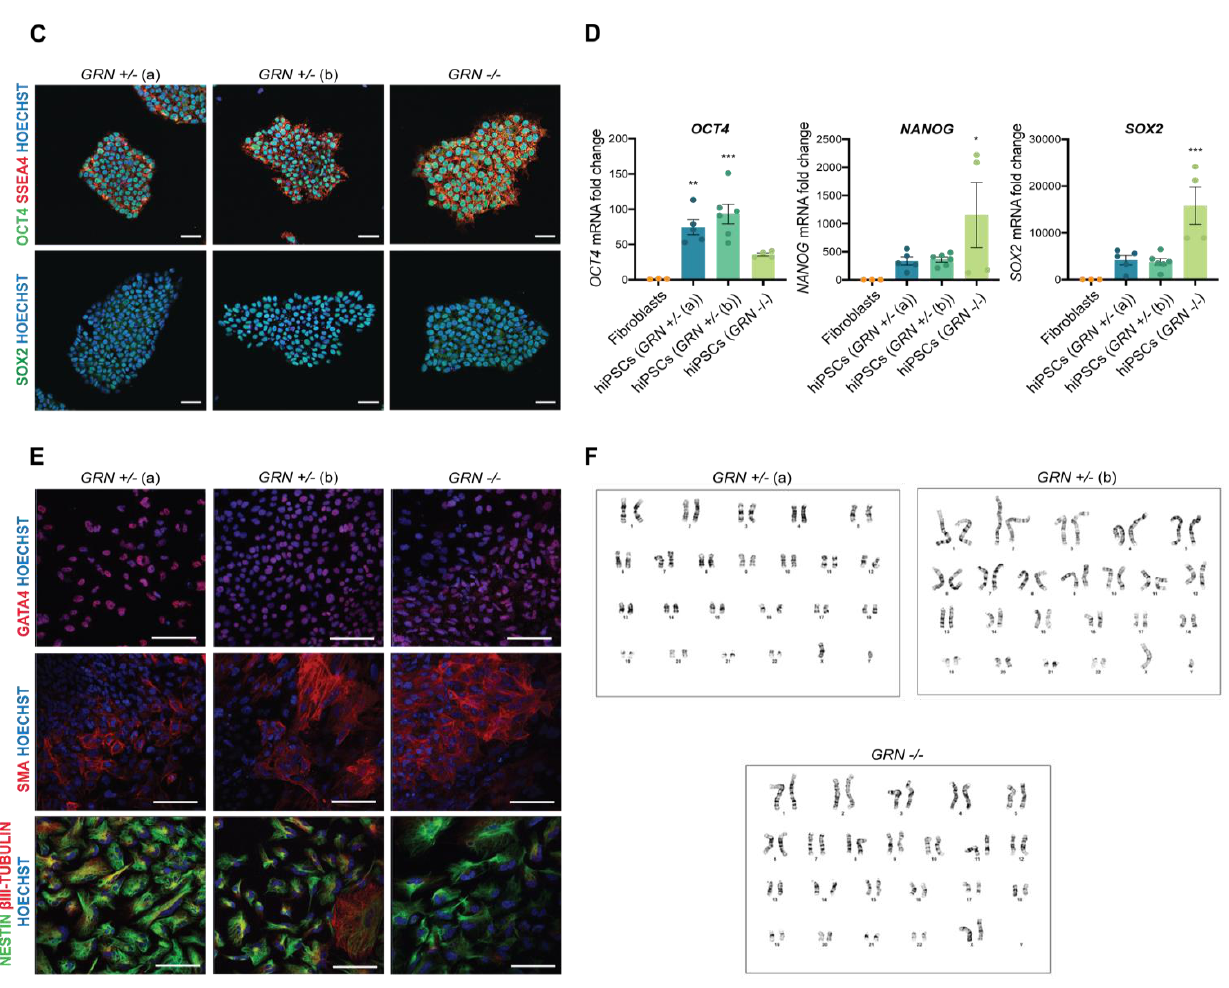
Figure 2. Generation and characterization of patient-derived hiPSCs. hiPSCs were generated from skin fibroblasts of three individuals, from the same family, all carriers of the progranulin mutation c.900_901dupGT. One individual harboring a homozygous mutation and two individuals harboring a heterozygous mutation. ( A ) Schematic representation of the protocol for fibroblast isolation and repro- gramming into hiPSCs. ( B ) Typical morphology of fibroblasts and hiPSCs following reprogramming (scale bar: 200 µ m). ( C ) Expression of pluripotency markers OCT4, SSEA4 and SOX2 was detected by immunocytochemistry in the three hiPSC lines (scale bar: 50 µ m). ( D ) Increased expression of pluripotency genes OCT4 , NANOG and SOX2, with respect to fibroblasts, was also observed by qPCR in at least two independent hiPSC colonies from each individual ( n = 3 fibroblast lines; n = 4 GRN +/ − (a) colonies; n = 5 GRN +/ − (b) colonies; n = 2 GRN − / − colonies). ( E ) Expression of trilineage markers GATA4 (endoderm), SMA (mesoderm) and NESTIN and β III-TUBULIN (ectoderm) (scale bar: 100 µ m) was determined by immunocytochemistry in the two most promising colonies of each hiPSC lines (described in Table 1), following the three germ layer assay. ( F ) A normal karyotype, with 46 chromosomes GRN +/ − (a): 46, XY, GRN +/ − (b): 46, XY, GRN − / − : 46, XX was identified in both colonies of the three hiPSC lines. One-way ANOVA, following Dunnett’s multiple comparisons test. Data are presented as mean ± s.e.m. Statistical significance: * p < 0.05, ** p < 0.01, *** p <